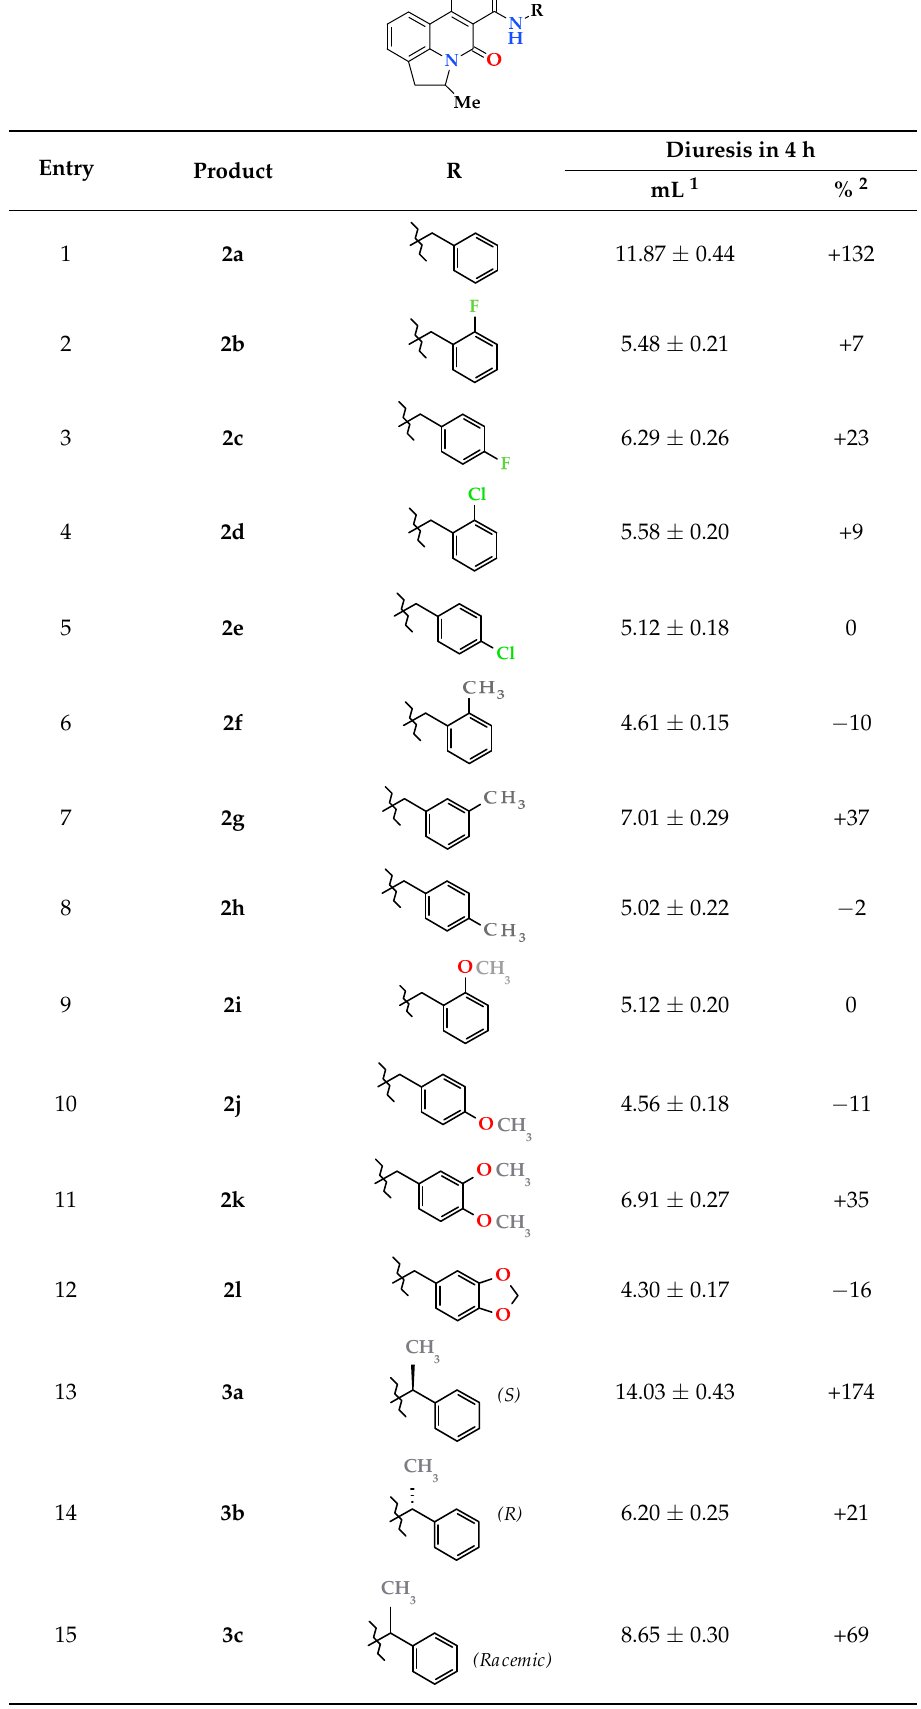
Table 1. The diuretic activity of N -Arylalkylamides 2 – 7 , and Hydrochlorothiazide.